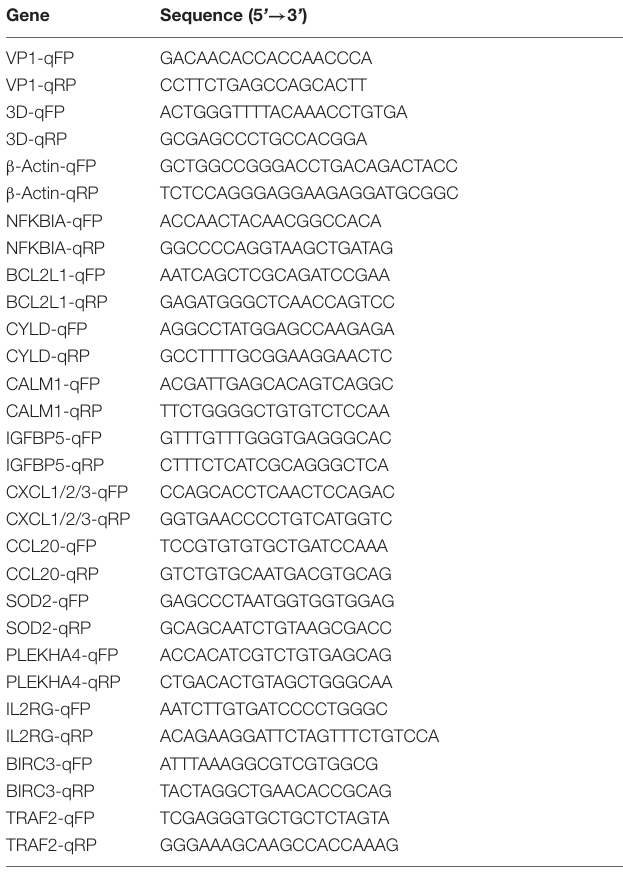
TABLE 2 | Primers used for RT-qPCR